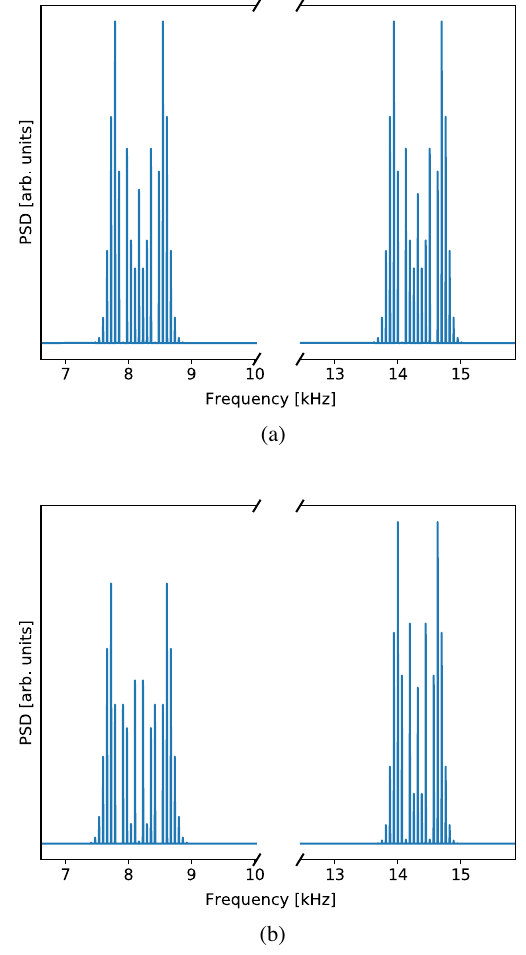
FIG. 1. Power spectral densities of a single particle ’ s dipole moment, presented for two different values of chromaticity. Typical for the LHC values of synchrotron amplitude, frequency, and betatron tune are assumed. (a) Q ξ ¼ 0 (b) Q ξ ¼ 20